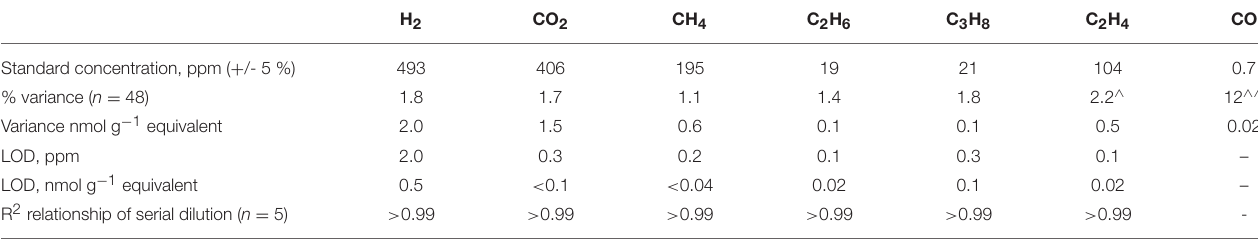
TABLE 2 | The limit of quantification (variance) and detection (LOD) for each gas analyzed.